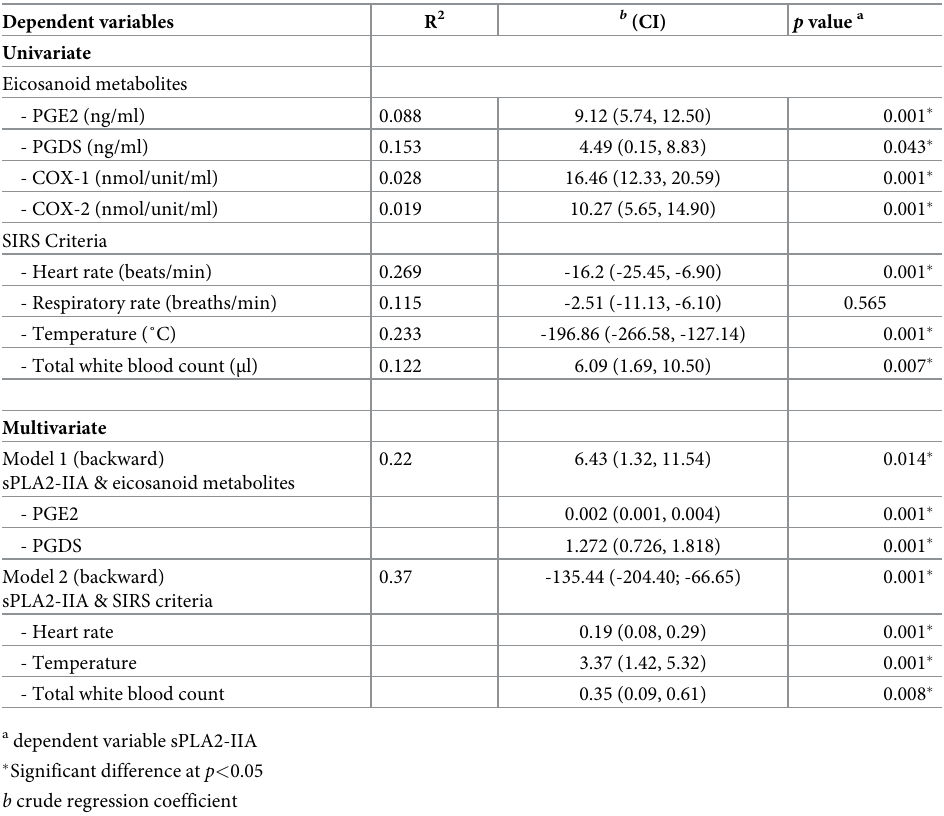
Table 3. Correlation, univariate and multivariate linear regression of sPLA2-IIA and eicosanoid metabolites and